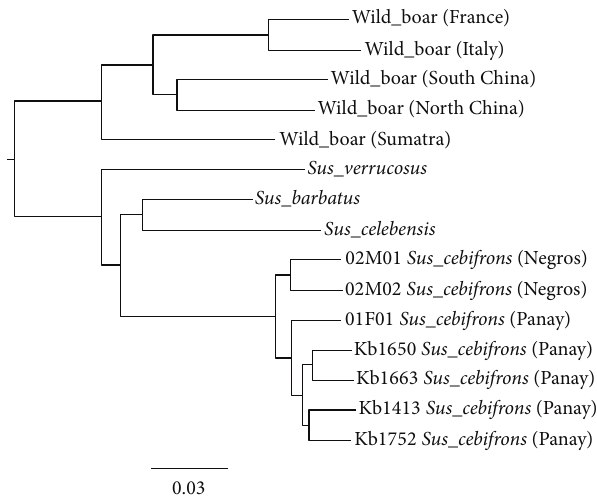
Figure 3: Neighbour joining, midpoint rooted phylogenetic tree of seven Sus cebifrons individuals, including other species for com- parison (for description, see Table S1 in Supplementary Material). Wild boar samples represent different populations of Sus scrofa . Within the Sus cebifrons cluster, a split is visible, separating the two individuals from Negros (top) and the five individuals from